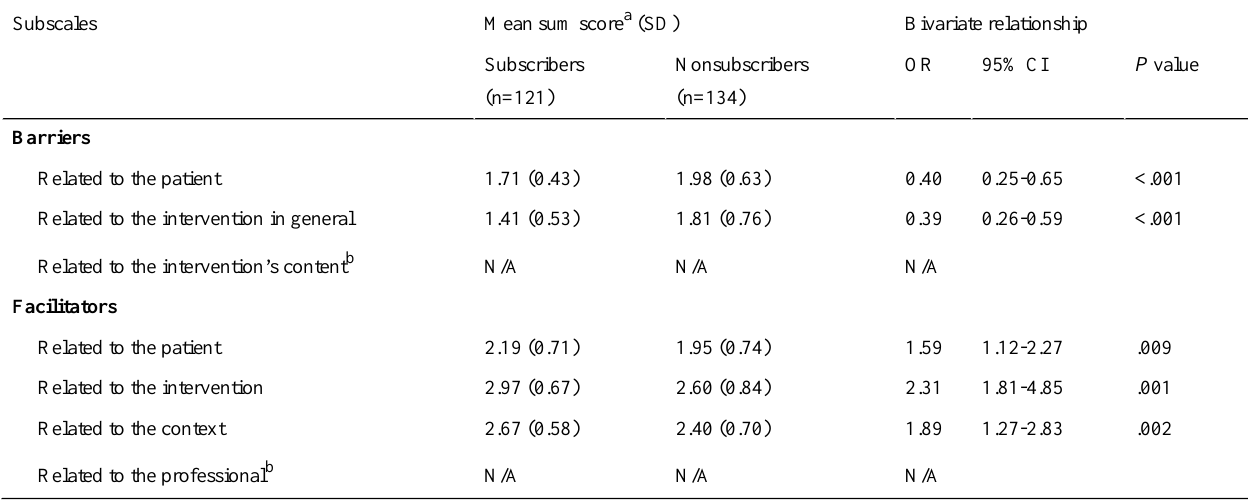
Table 3. Means (range 1-4), standard deviations, and bivariate relationships of subscribers versus